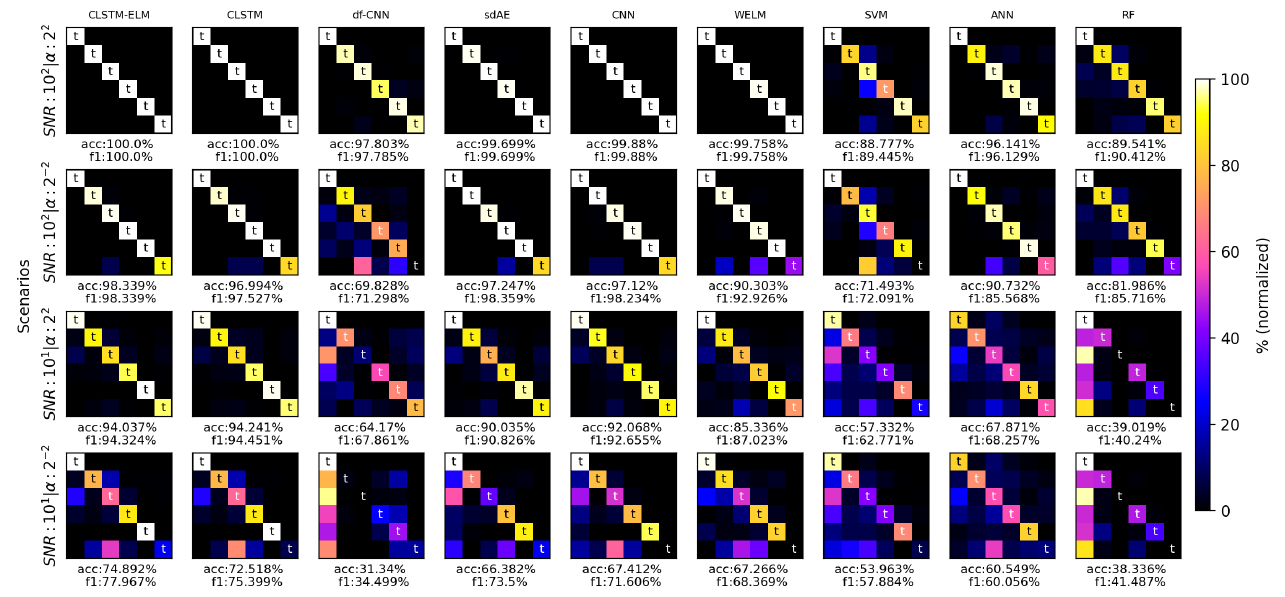
Figure 13. Confusion matrices and f 1 -scores of the comparison panel with classic augmentation in different scenarios (t represents true labeled samples).